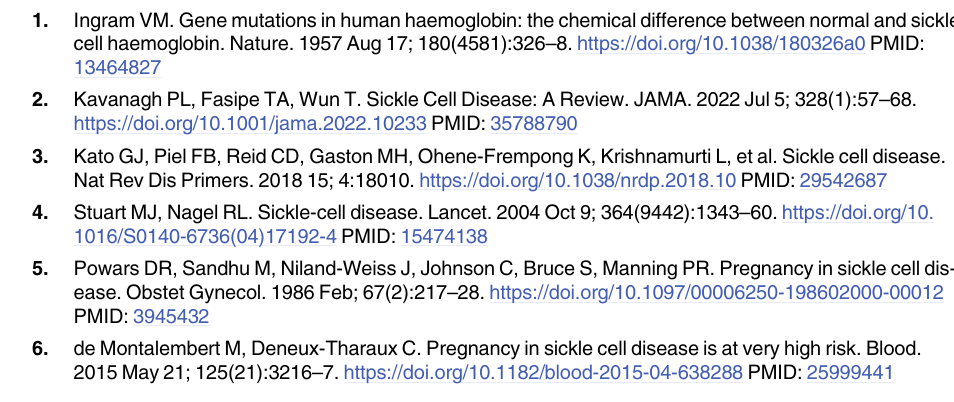
S2 Table. DMPs list and methylation beta-value for each patient in the HbSS, HbSC and Control groups. S3 Table. DMRs identified from the comparison between HbSS and HbSC groups versus control group. S4 Table. Data of gene expression levels for each studied